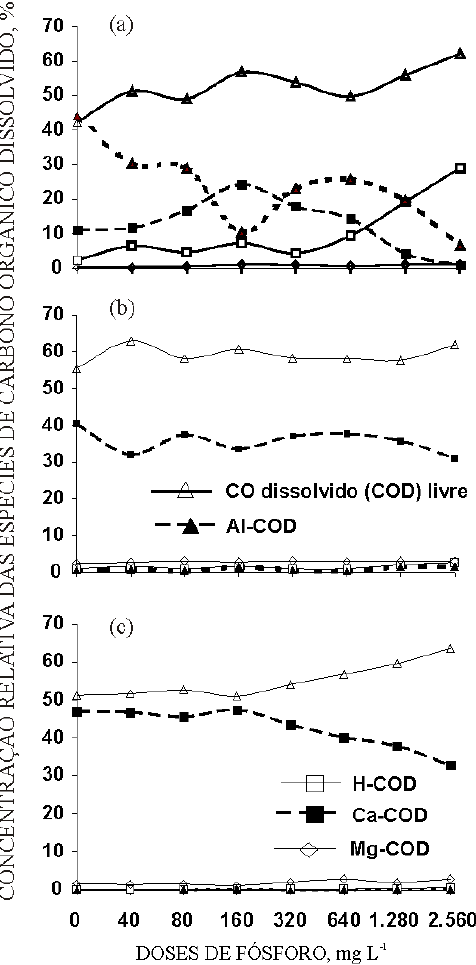
Figura 6. Concentração relativa de espécies de carbono orgânico dissolvido (COD) na solução de um Latossolo Vermelho distrófico típico, cultivado, por sete anos, no sistema plantio direto em diferentes condições de acidez: pH 4,0 (a); pH 4,5 (b) e pH 6,4 (c) e submetidas a aplicação de doses de